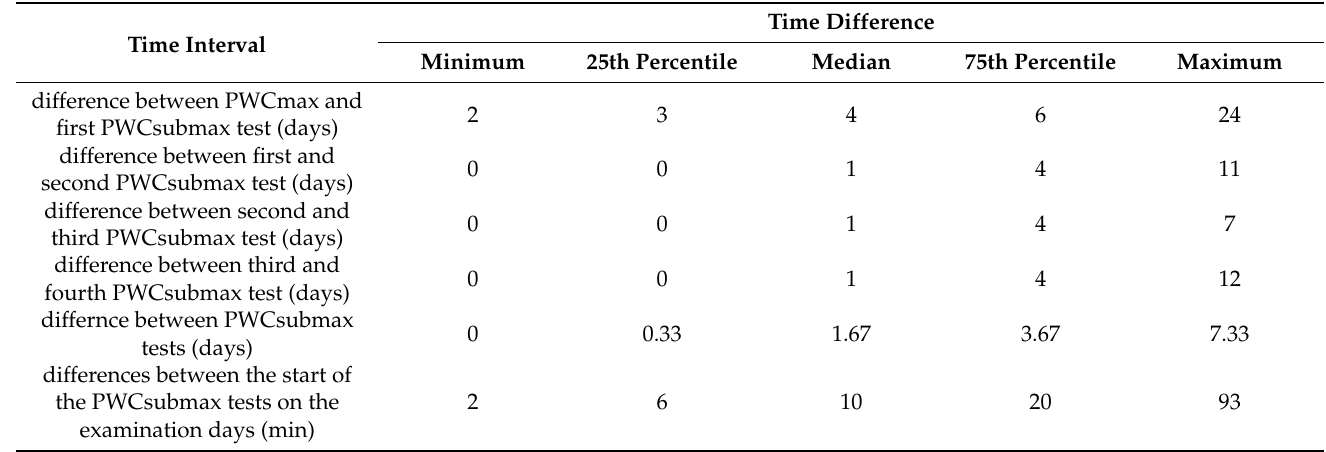
Table A2. Time intervals between the maximum and submaximum bicycle ergometer